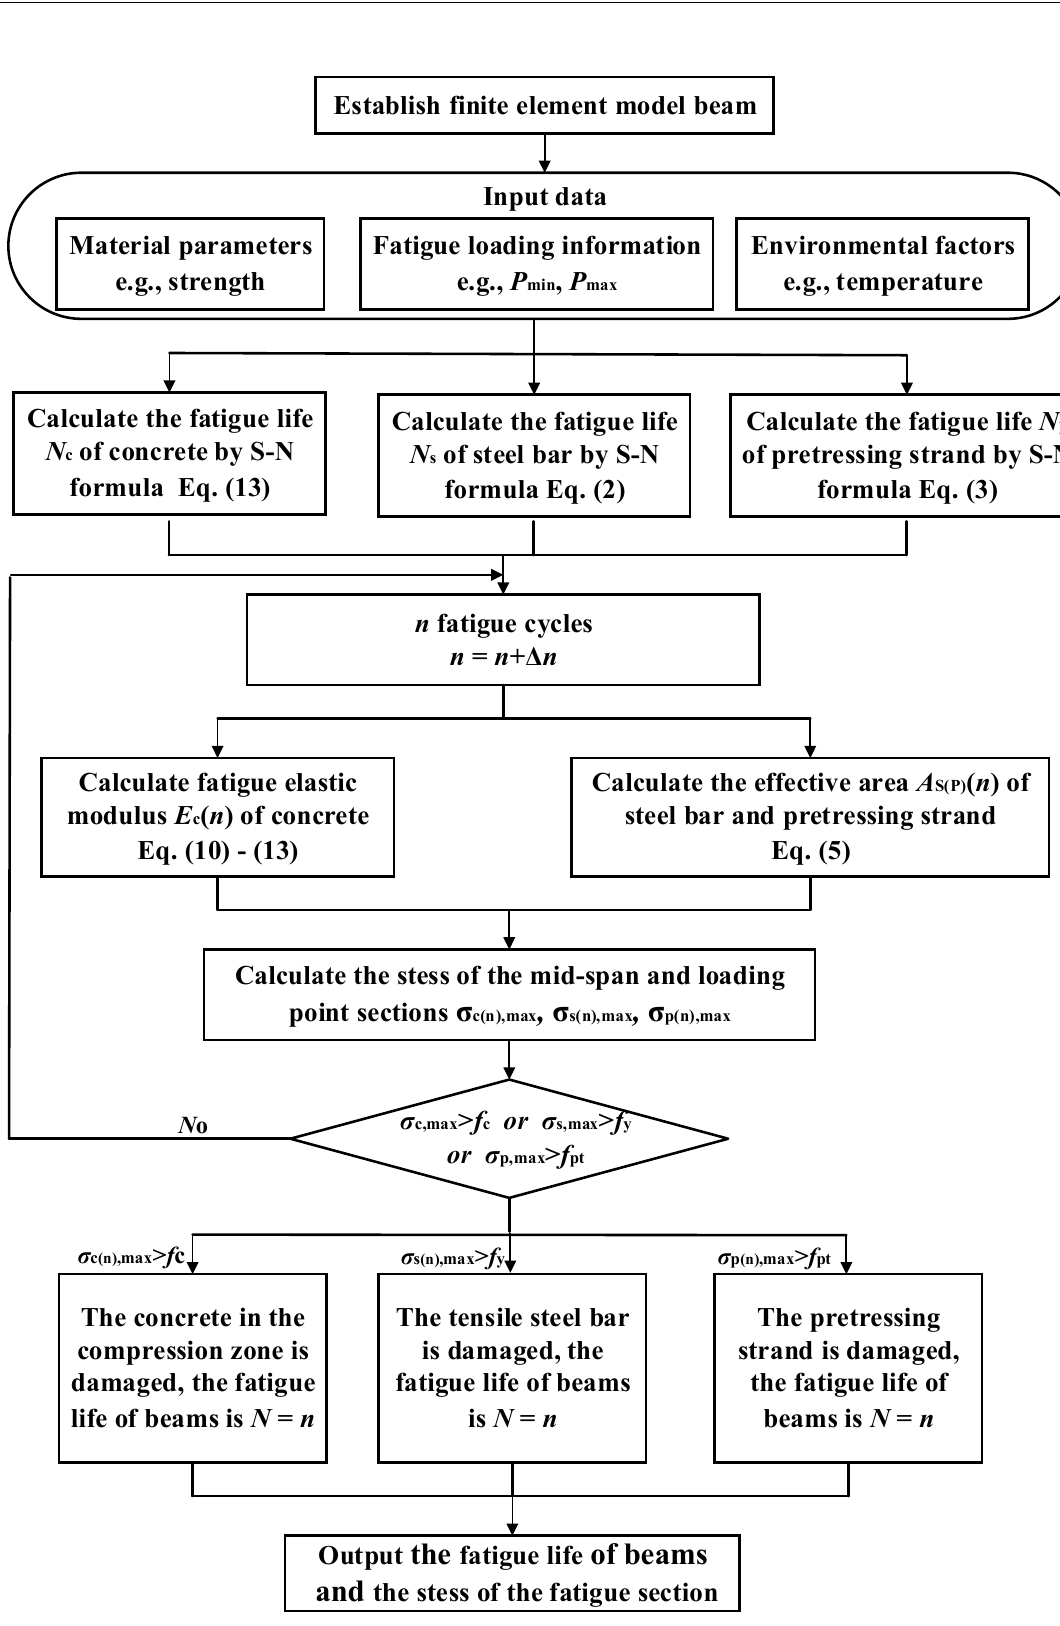
Figure 22. The fatigue behavior analysis process of prestressed concrete beams.